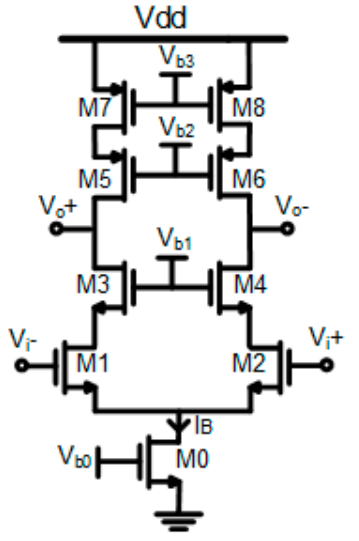
Figure 4. Telescopic Cascode OTA.